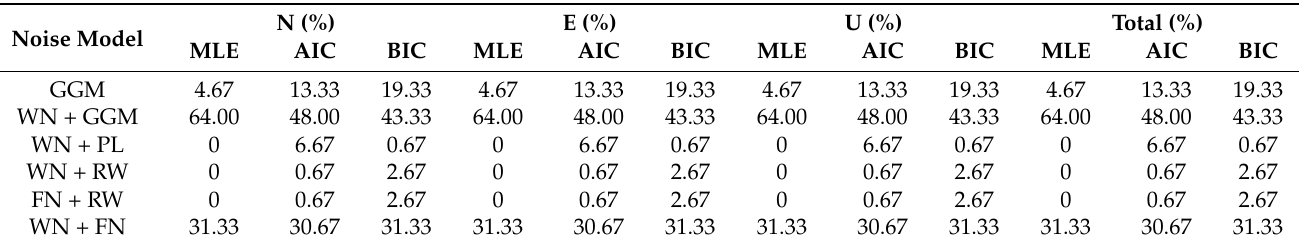
Table 1. Statistics of each noise model which has the lowest MLE, AIC, and BIC information crite- rion values for the N, E, and U directions.